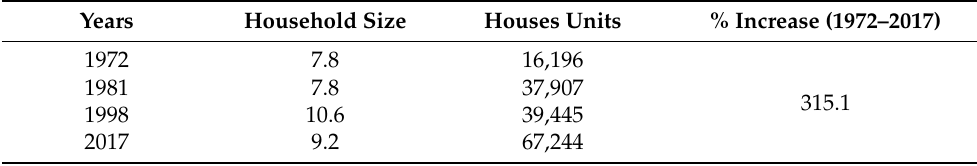
Table 7. Household size and housing units in District Kurram.